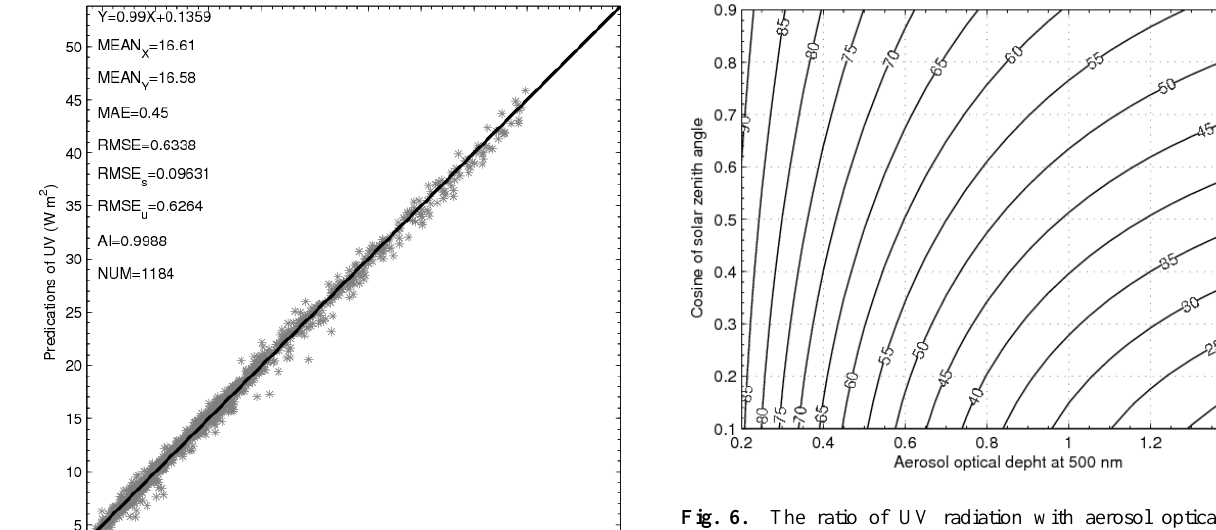
Fig. 6. The ratio of UV radiation with aerosol optical depth Figure 6. The ratio of UV radiation with aerosol optical depth at 500 nm changing at 500nm changing from 0.2 to 1.5 to that under background from 0.2 to 1.5 to that under background condition with aerosol optical depth at 500 condition with aerosol optical depth at 500nm equal to 0.1, i.e. UV (τ 500nm ,µ) × 100. nm equal to 0.1, i.e., UV (τ 500nm = 0 . 1 ,µ)